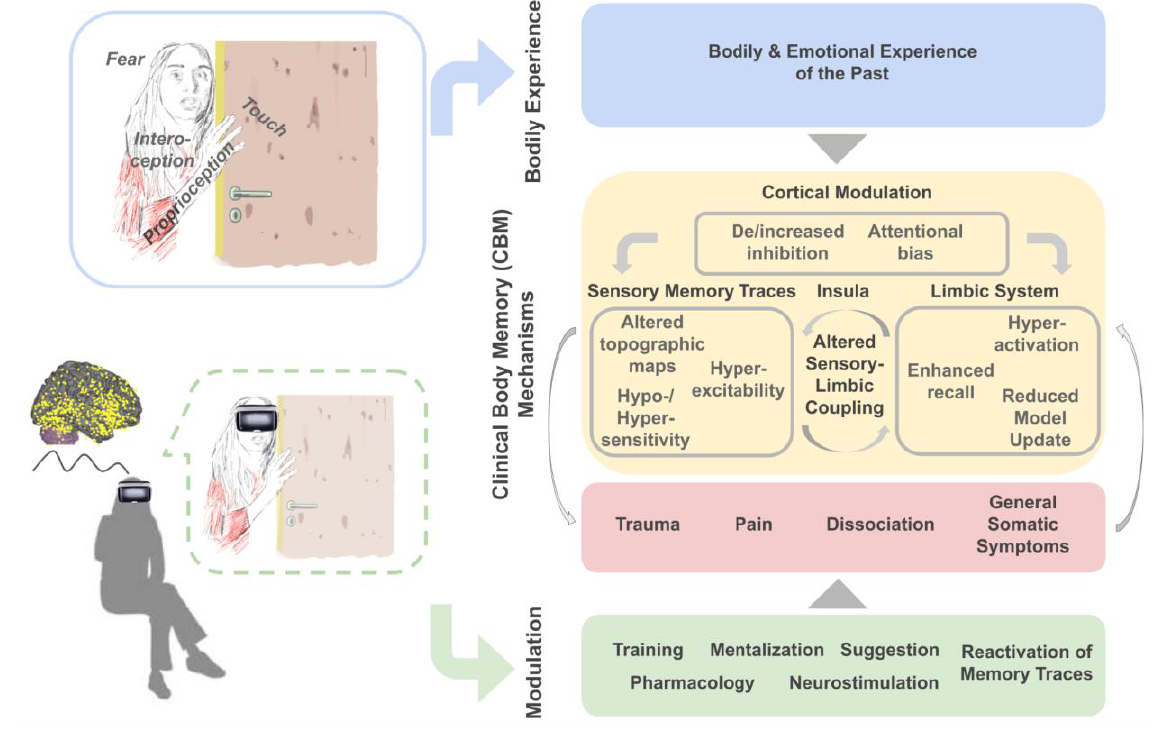
Figure 1. Clinical Body Memory (CBM) Mechanisms. The key hypothesis discussed here is that stored bodily experiences of the past and associated emotions (blue boxes) can contribute to the development of Clinical Body Memory (CBM) mechanisms including trauma, pain, dissociation and general somatic symptoms (red box) via neuronal and cognitive mechanisms that mediate their storage and retrieval (yellow box). Experimental investigation may allow empirical access and modulation of CBMs (green box), for example, via using Virtual Reality (VR) paradigms (left bottom).